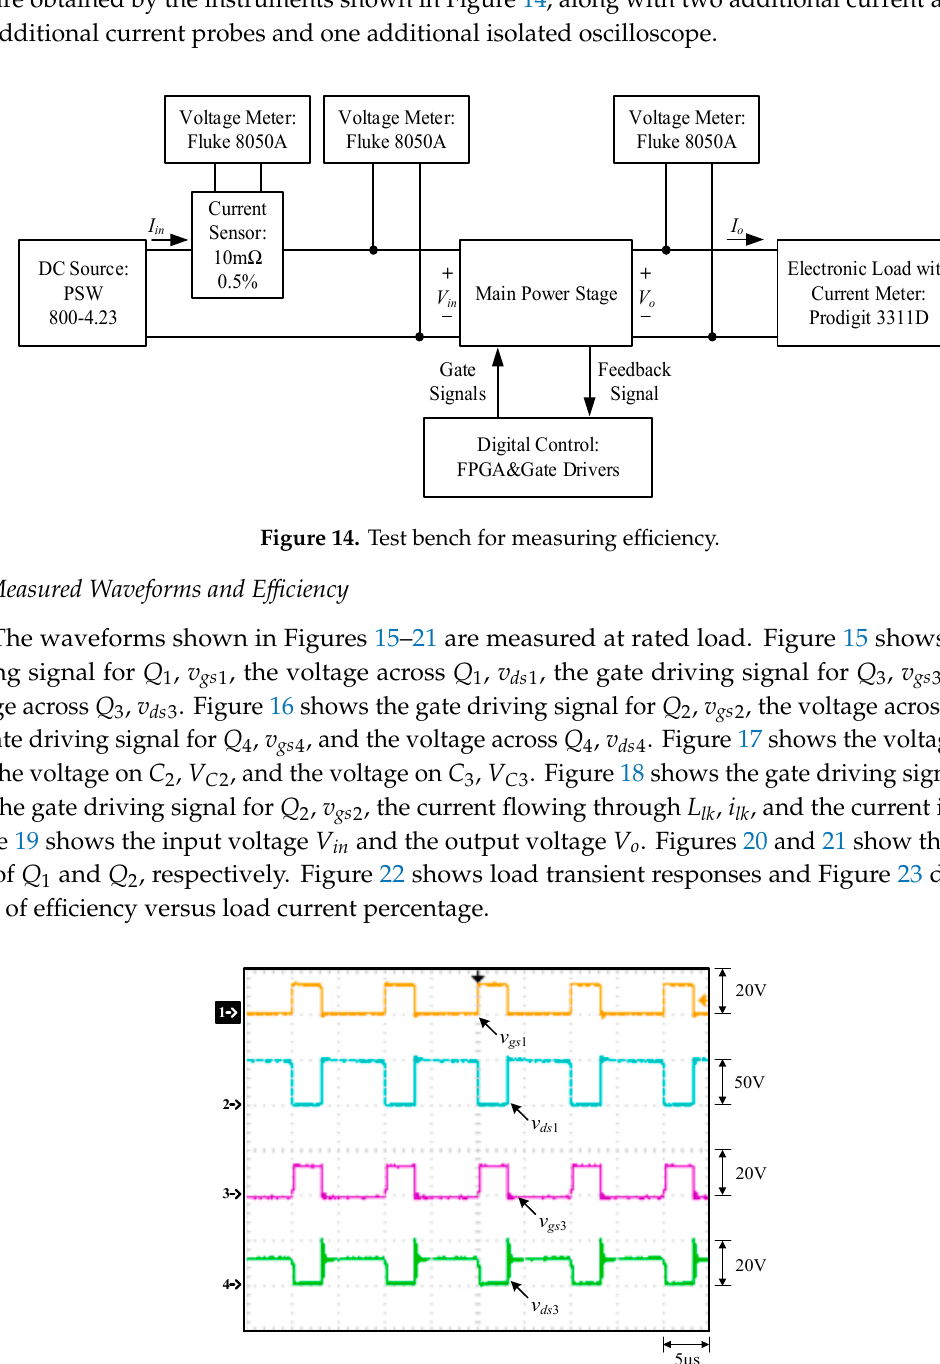
v ds 4 Figure 16. Measured waveforms at rated load: (1) v gs 2 ; (2) v ds 2 ; (3) v gs 4 ; (4) v ds 4 .